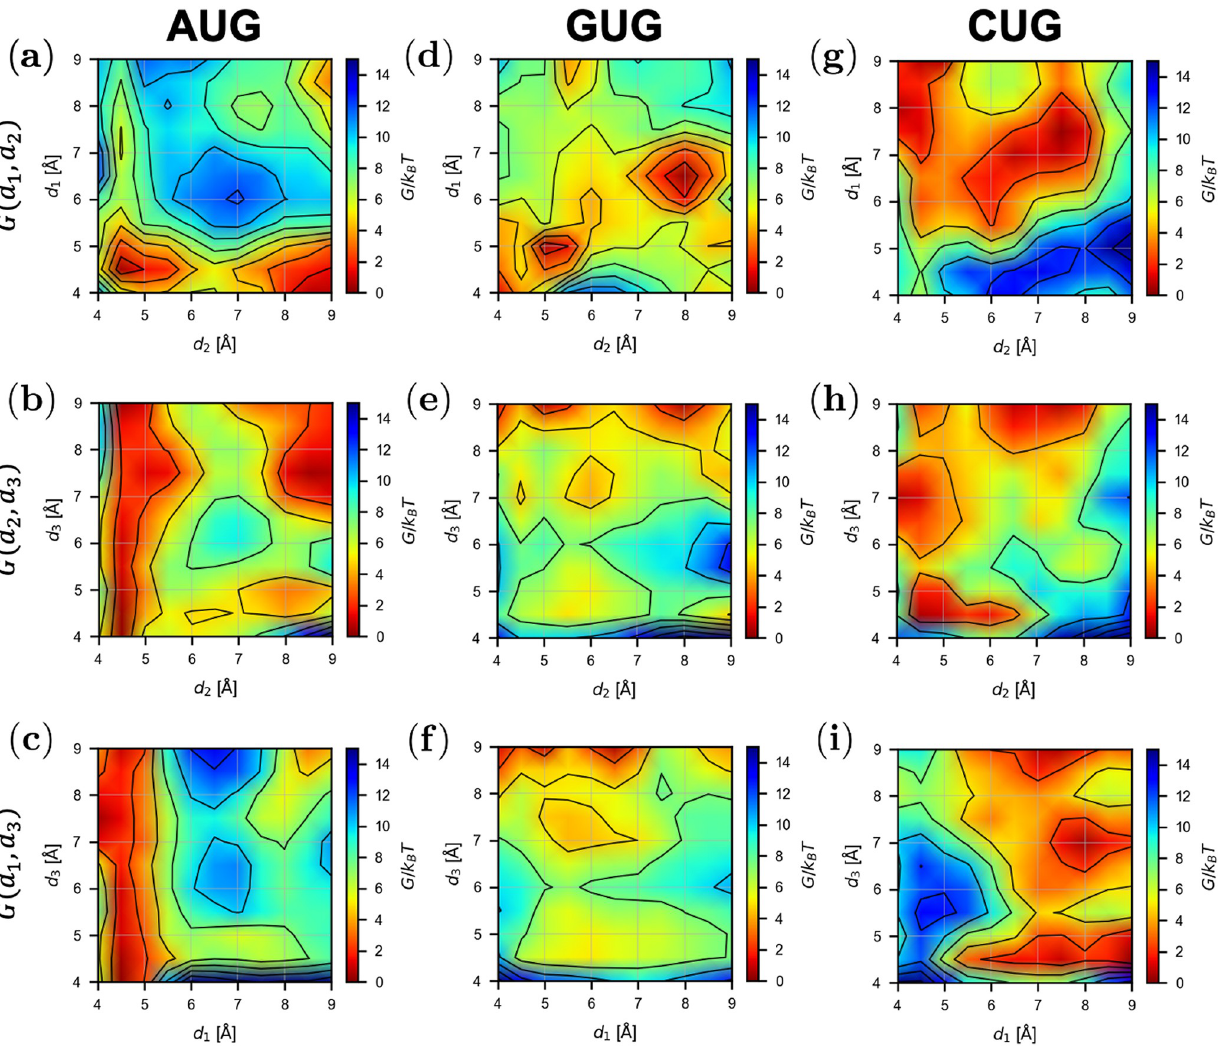
Fig 5. Projected free energy profiles. Profiles of G ( d 1 , d 2 ), G ( d 2 , d 3 ), and G ( d 1 , d 3 ) obtained from Eq 4 for each model is shown by contour